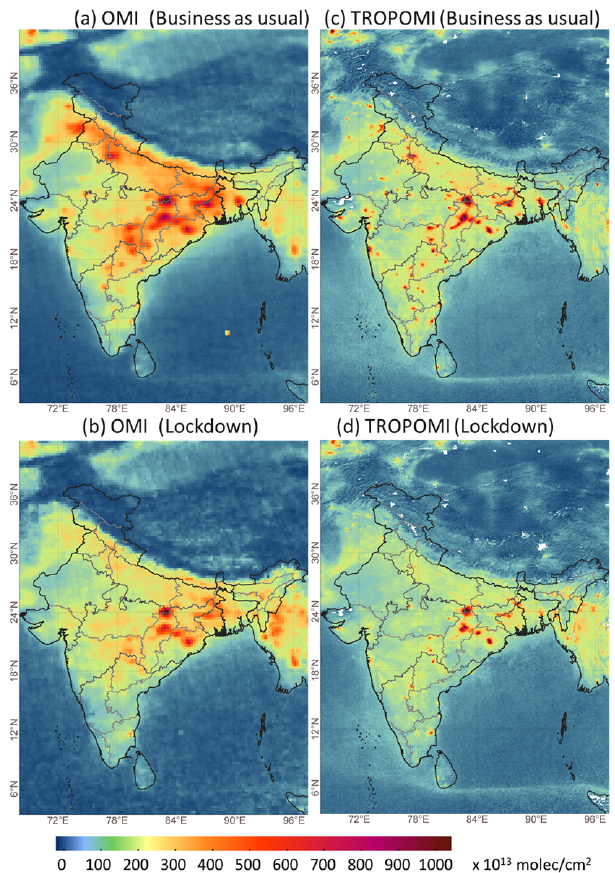
Figure 3. Spatial distribution of mean VCD trop NO 2 (molec.cm − 2 ) during the analysis period (25 March–3 May) for (a) OMI NO 2 dur- ing business as usual (BAU, 2016–2019), (b) OMI NO 2 during the lockdown (LDN, 2020), (c) TROPOMI NO 2 during BAU (2019), and (d) TROPOMI NO 2 during LDN (2020).